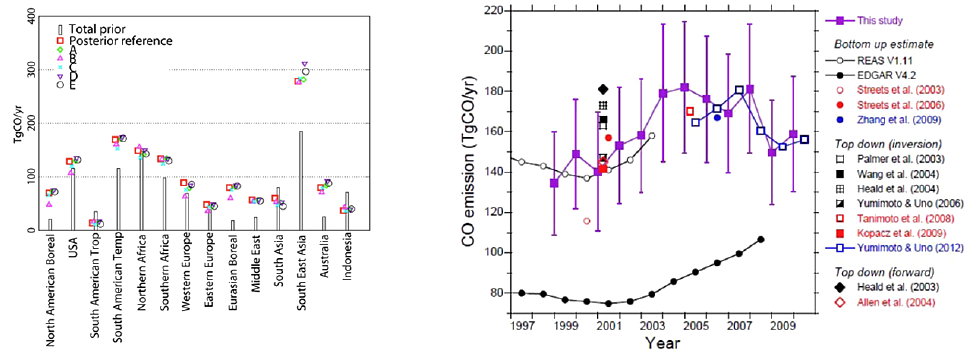
Figure 22. Left panel: annual total posterior CO emissions per region for year 2004 compared to the a priori reference: the different cases correspond to tests on different errors in the model (Fortems-Cheiney et al., 2011). Right panel: comparison of estimated CO annual emissions in China from inventories and inverse studies; “This study” refers to a top-down estimate (Tohjima et al., 2014).